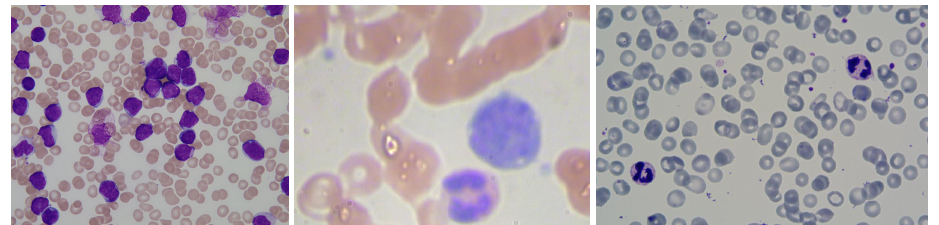
Figure 9. Sample images extracted from the described datasets. From left to right: ALL-IDB1, SMC-IDB, and IUMS-IDB sample